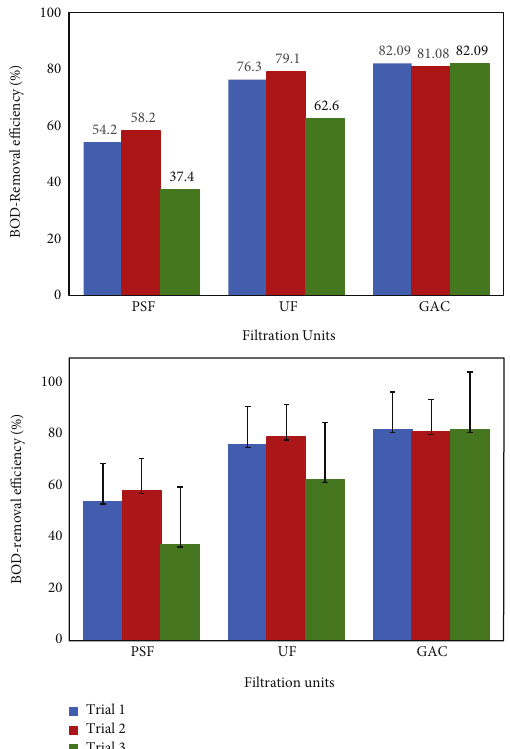
Figure 9: Bar chart representing the removal e ffi ciency of pollutants in PSF, UF, and GAC.